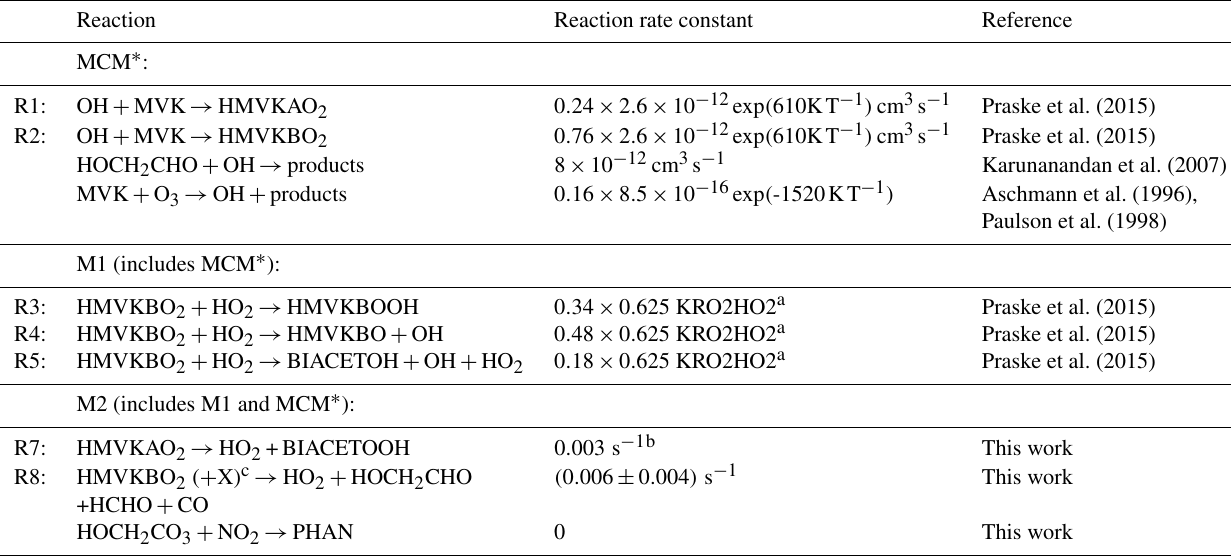
Table 1. Changes of reactions and additional reactions applied to the MCM. Reaction Reaction rate